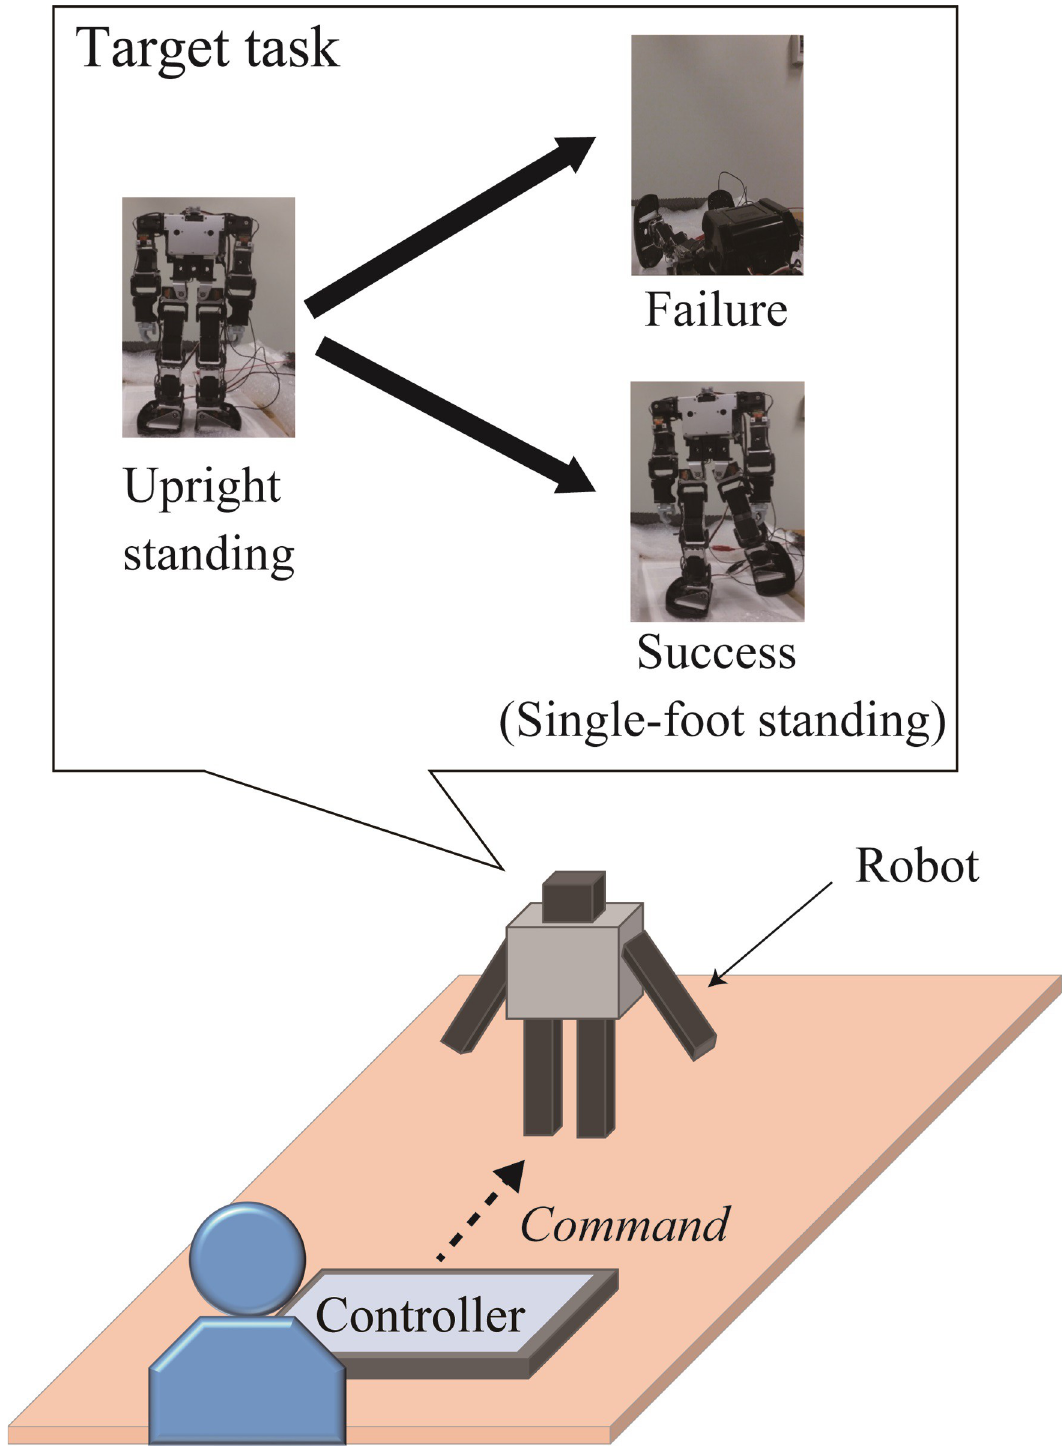
Fig 1. Overview of the target